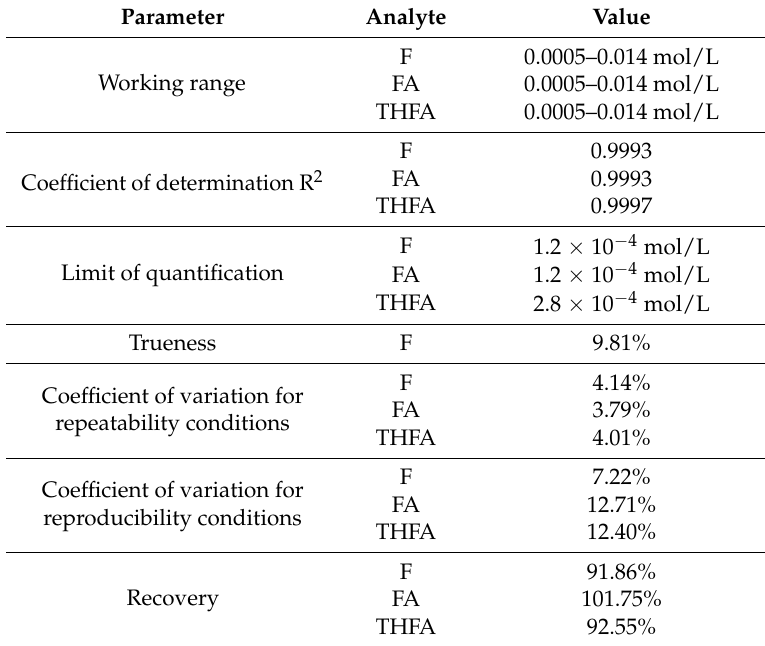
Table 10. Summary of validation parameters for GC-FID analysis of F, FA and